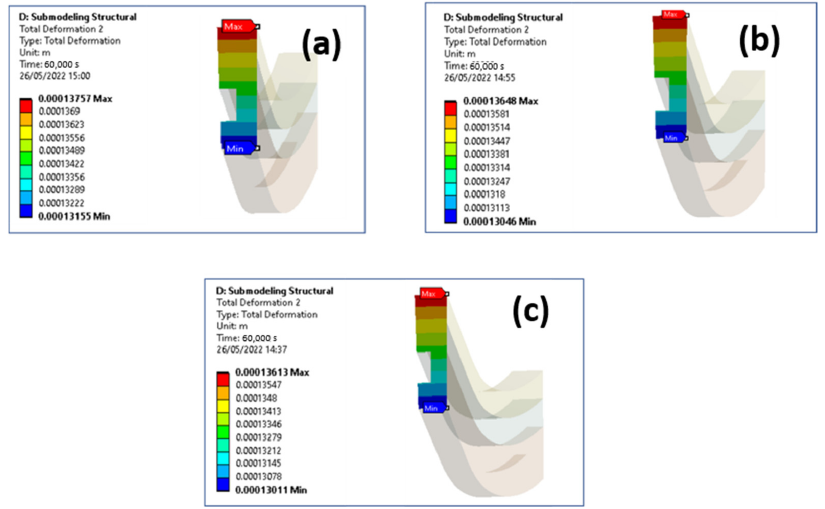
Figure 11. Total displacement contour plot (end of 15th cycle) at a cut boundary considering: ( a ) 3 global model cycles, ( b ) 5 global model cycles, ( c ) 10 global model